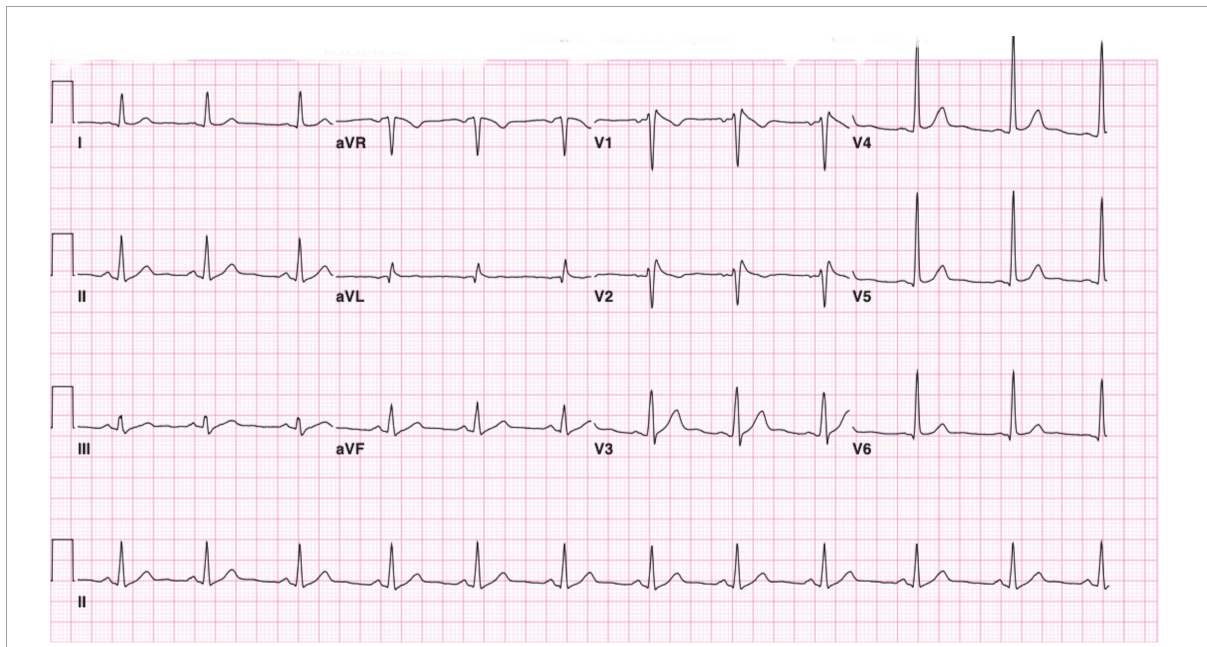
FIGURE1 Twelve-lead electrocardiogram demonstrating 2 mm ST segment elevation in leads V1 and V2 with a prominent J wave followed by negative T waves. Suggestive of a type 1 Brugada